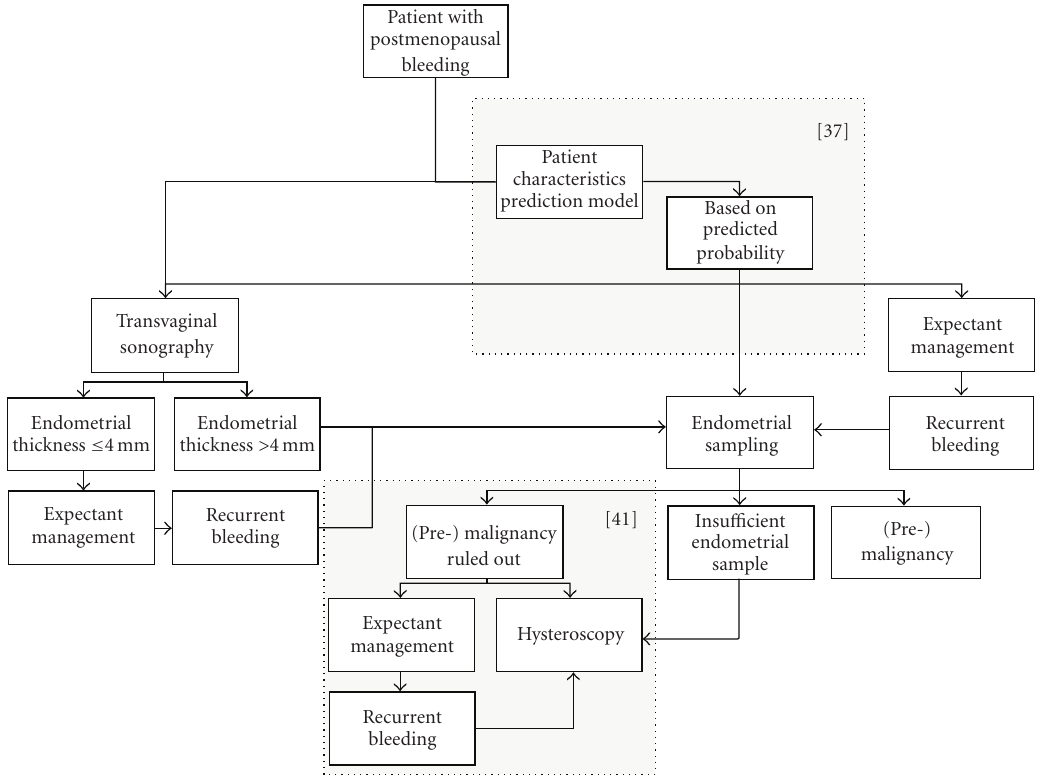
Figure 1: Possible diagnostic pathways for postmenopausal bleeding. The areas surrounded by a dotted square require futher research.